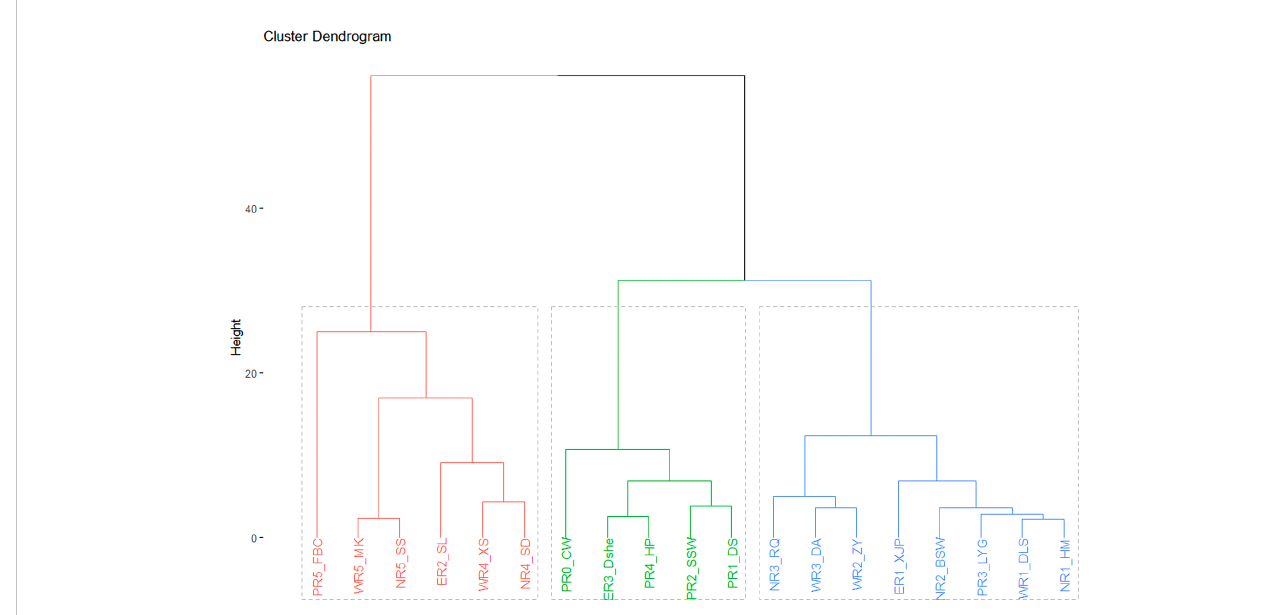
FIGURE 2 K-mean cluster diagram of the hydrological stations based on standardized tidal variables in the PRE,